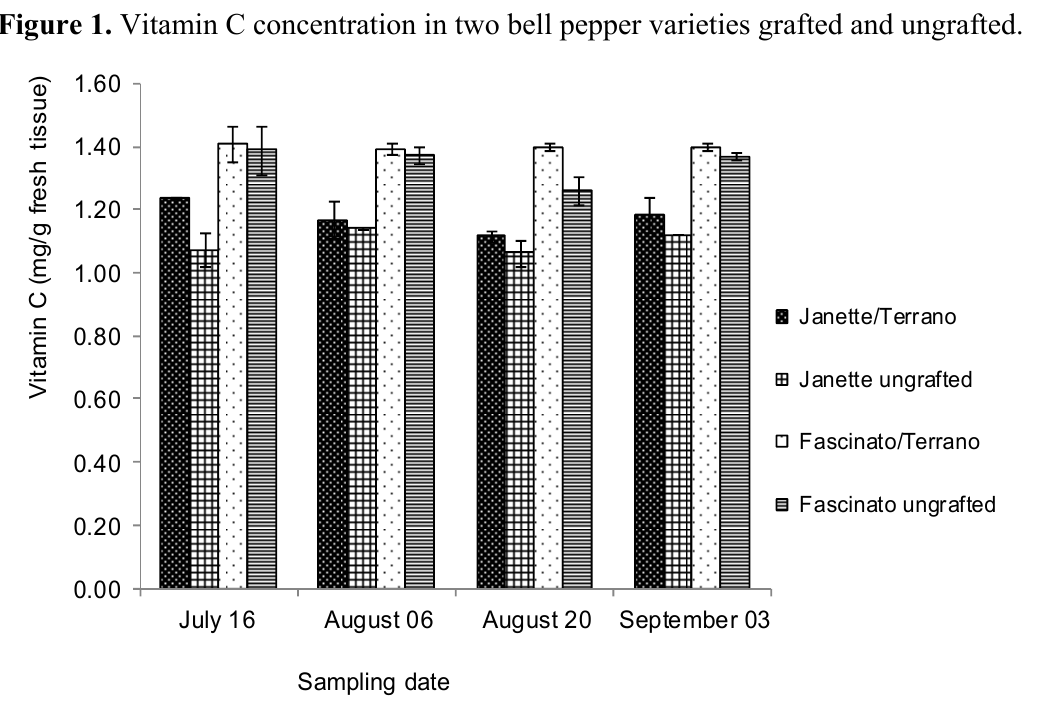
Figure 1. Vitamin C concentration in two bell pepper varieties grafted and